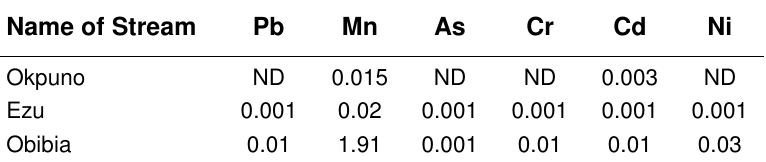
Concentration of Metals (mg/l) in Nearby Streams